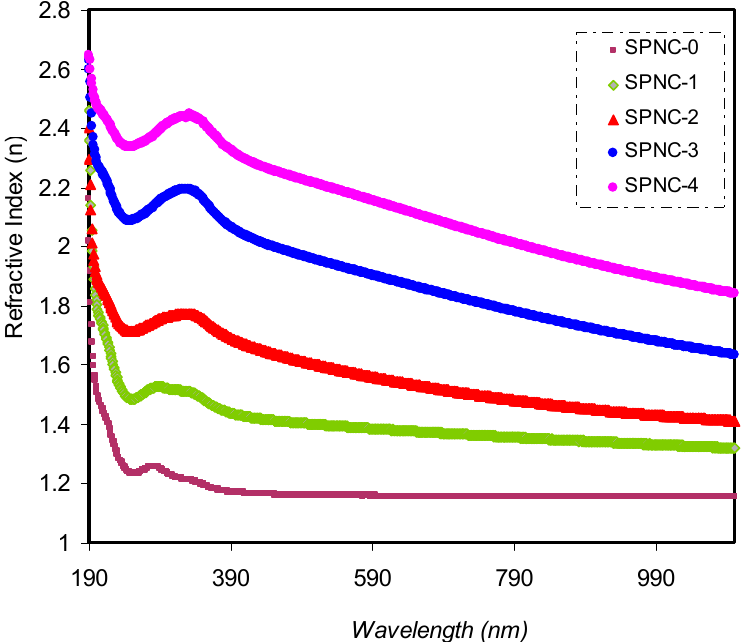
Figure 6. Increased refractive index (n) of the CeO 2 -doped samples relative to the pure PVA sample over a wide range of wavelength.